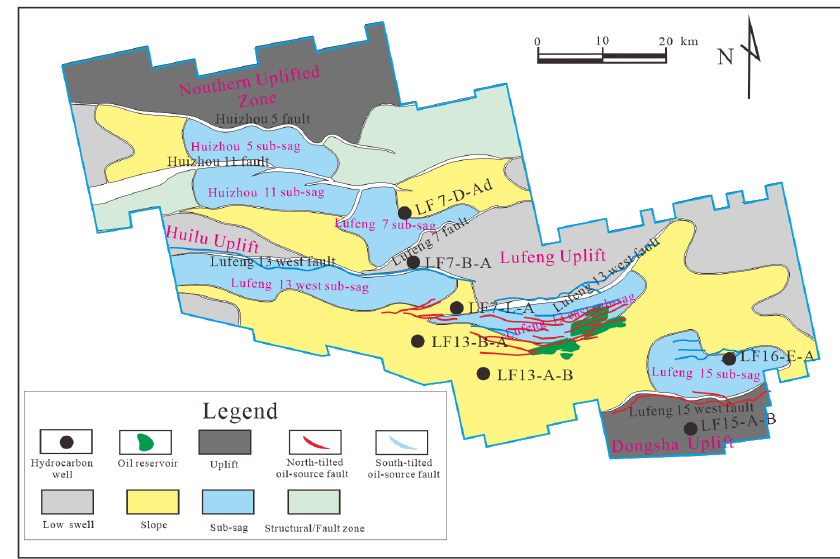
Figure 12. Distribution map of oil – source fault and non-oil – source fault on the plane .